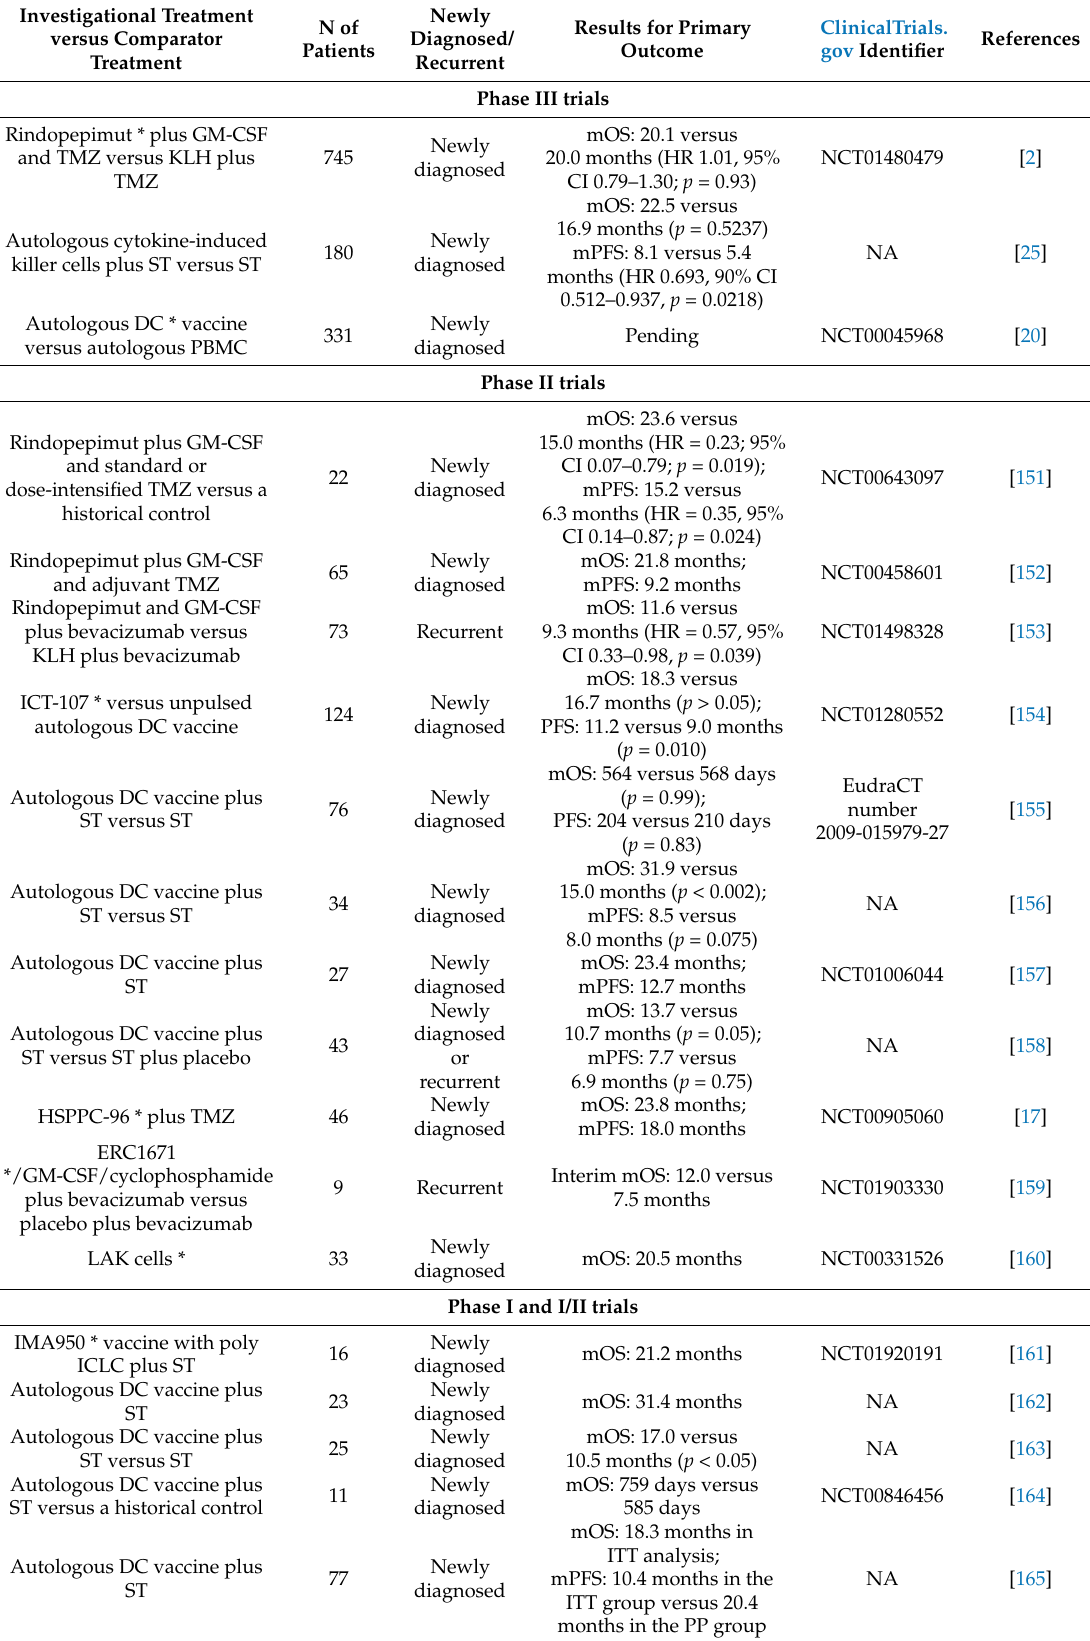
Table 3. Completed phase I–III clinical trials of vaccines for glioblastoma with primary outcomes. Investigational Treatment versus